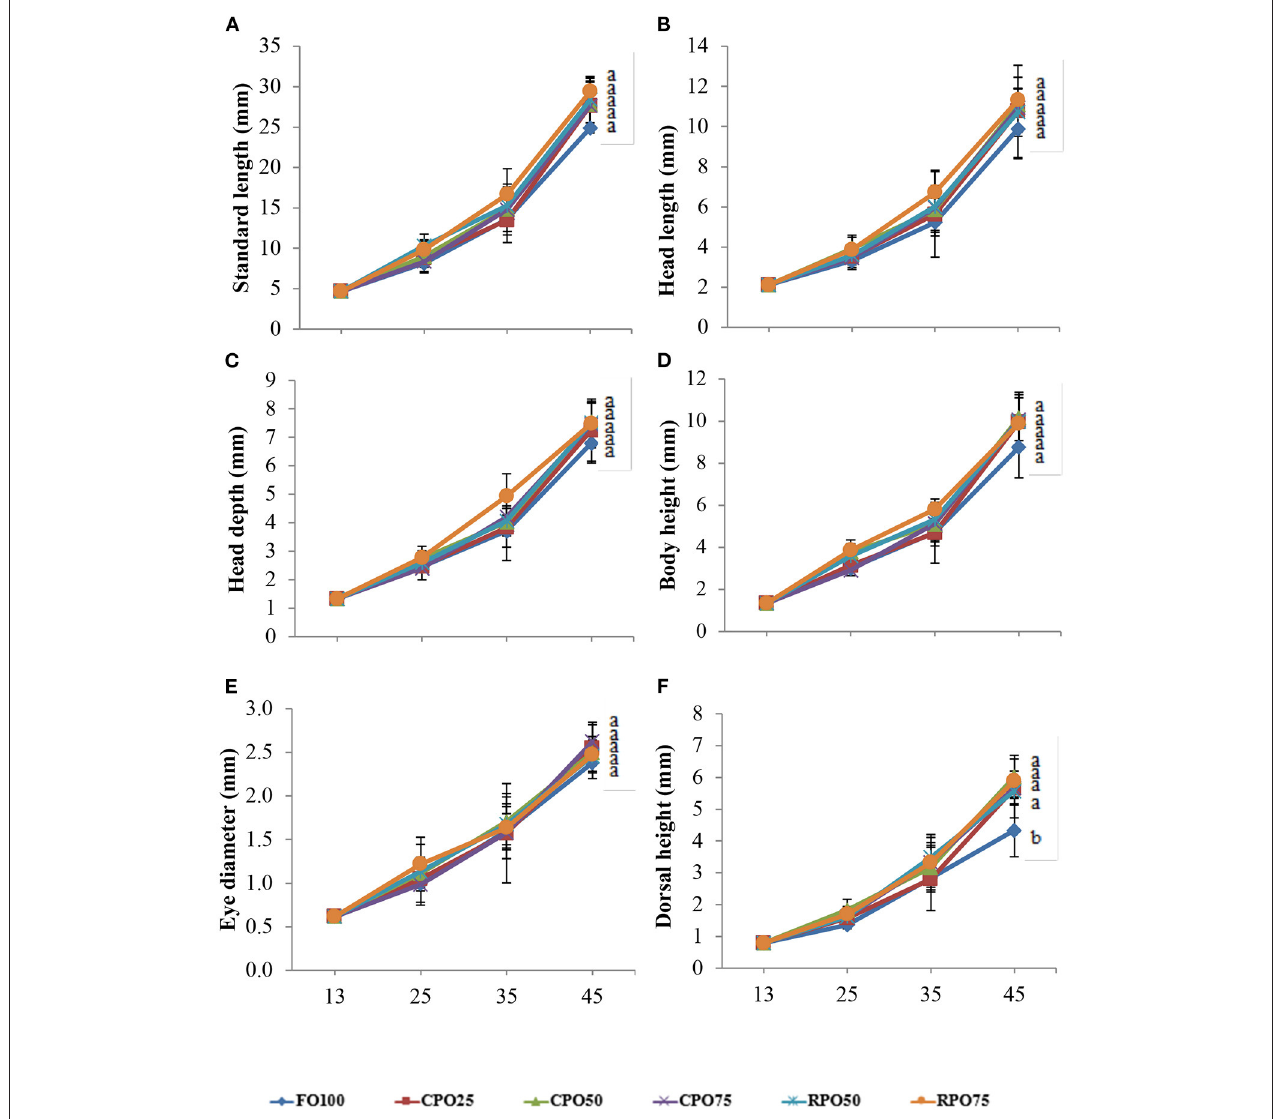
FIGURE 3 | Morphometric changes of Asian seabass fed different microdiets within 33 days experiment period. (A) Standard length (mm), (B) body height (mm), (C) head length (mm), (D) head depth (mm), (E) eye diameter (mm), (F) dorsal height (mm), means with different superscripts are significantly difference between treatments (Duncan’s multiple range test, P <